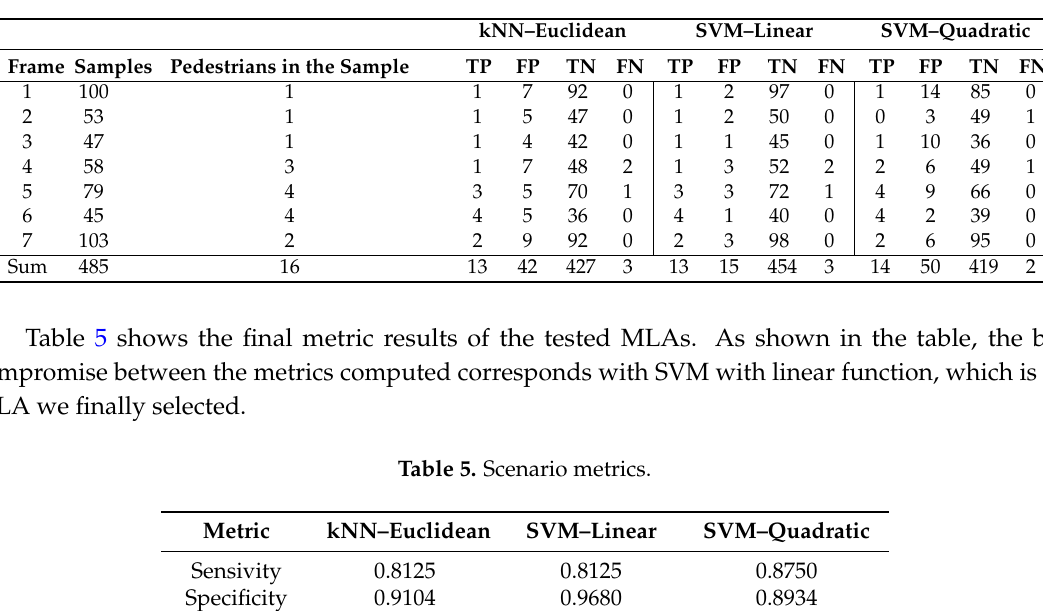
Table 4. TP, FP, TN and FN computed seven frames of scenario 3.